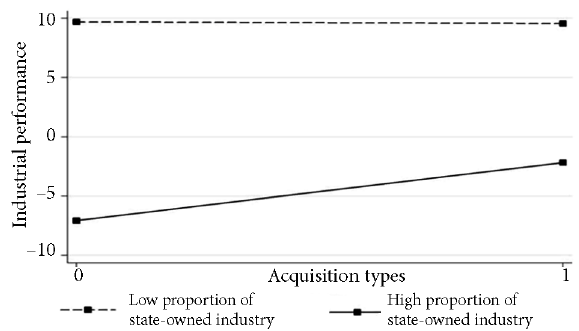
Figure 2. Moderating role of industrial state-owned